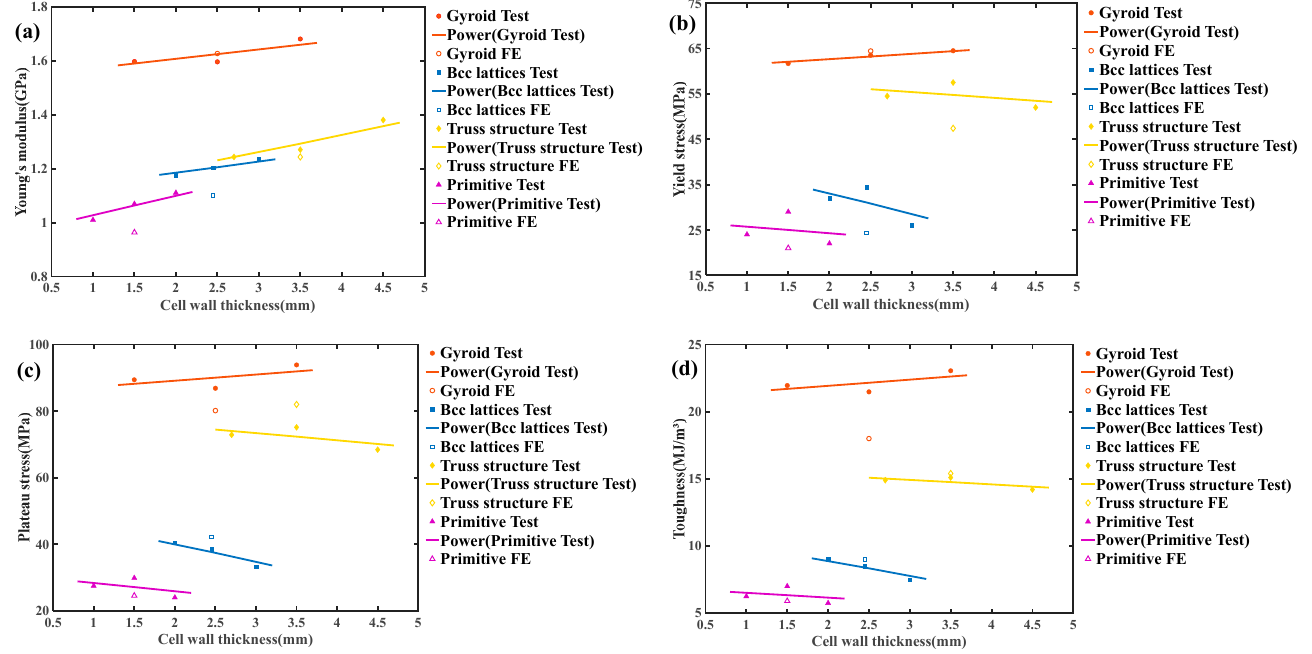
Figure 8. Normalized mechanical properties with respect to the measured relative density: ( a ) Young’s modulus, ( b ) yield stress, ( c ) plateau stress, ( d ) toughness. Solid lines indicate the best fit- ting lines of experimental data using power laws.